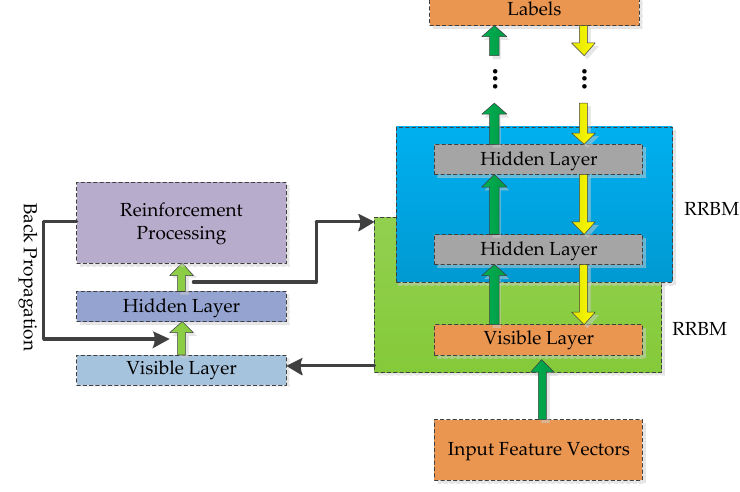
Figure 8. The structure of Figure 8 . The structure of RDBN. Figure 8 . The structure of RDBN.